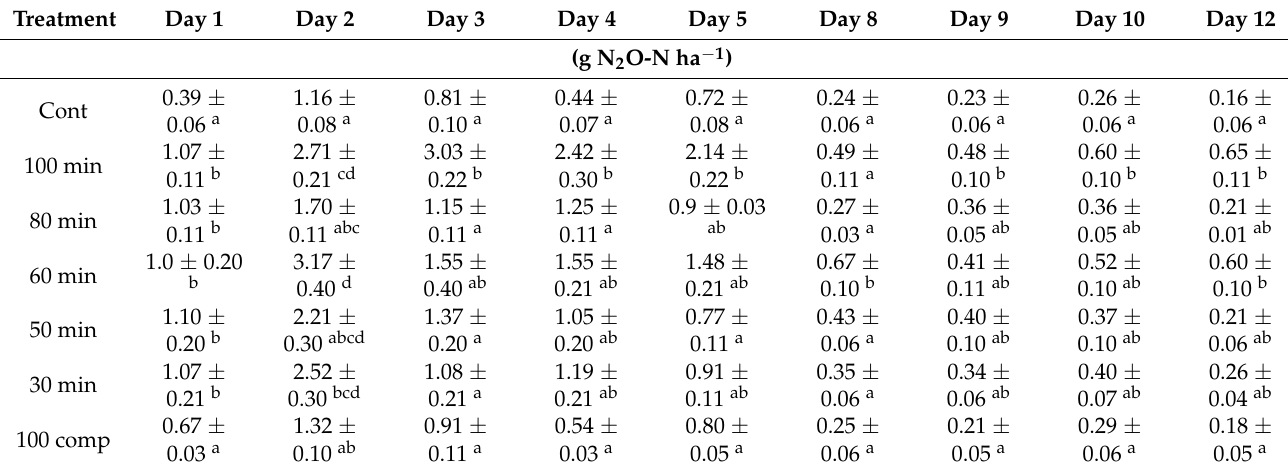
Table A2. Daily emission of nitrous oxide (N 2 O) at 75% water-filled pore space in different fertilizer treatments (incubation experiment). Only the days with significant differences between the treatments are listed.